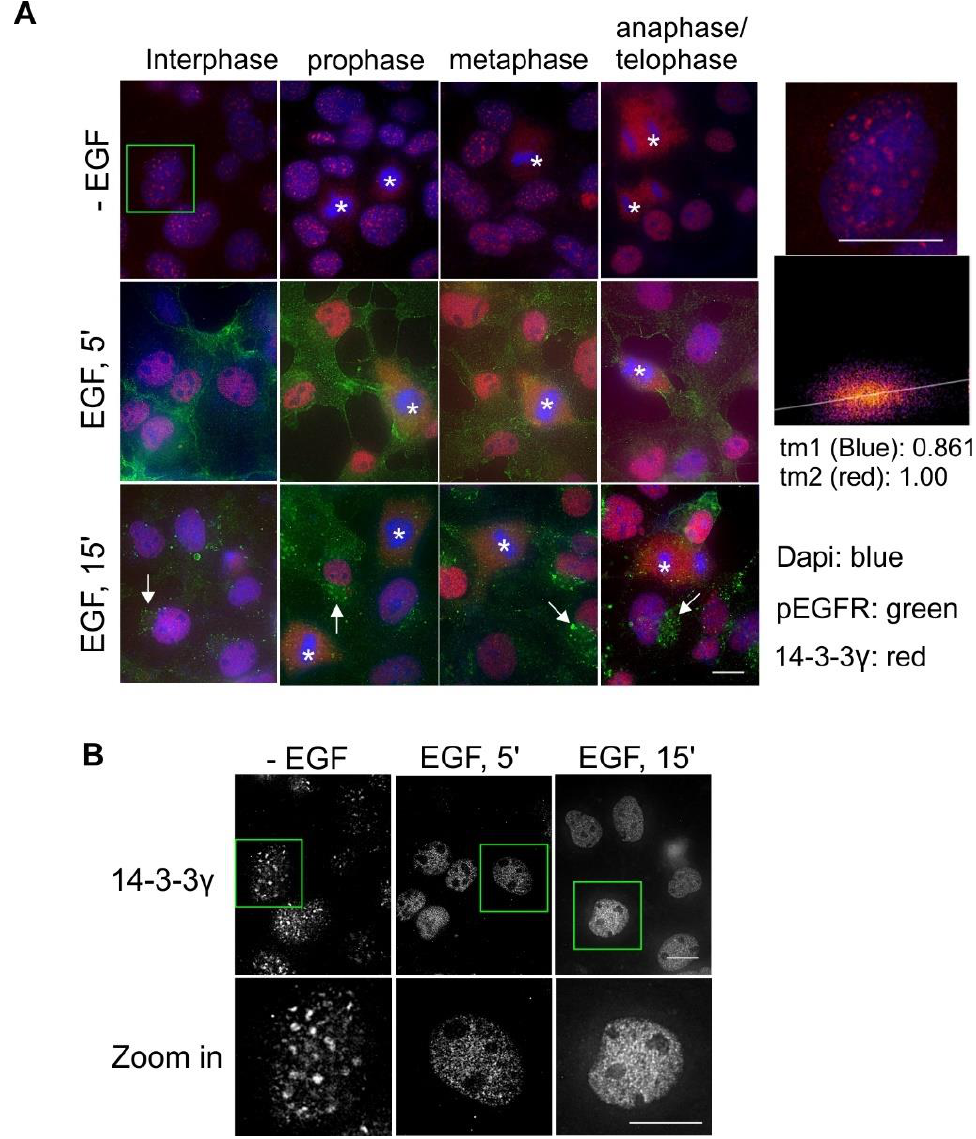
Figure 7. Subcellular localization of 14-3-3γ in Cos-7 cells by double indirect immunofluorescence. ( A ) Subcellular localization of 14-3-3γ during the cell cycle and in response to EGF. With or without EGF stimulation, 14-3-3γ (red) and pEGFR (green) were revealed by double indirect immunofluorescence. Mitotic cells are labeled by * and endosomes are marked by arrows. The zoomed-in areas were used to calculate Mander’s coefficients between blue and red channels. ( B ) Black and white images highlight the changes in the 14-3-3γ stain. The three images are the same as the three images in the far left panel in (A). Scale bar = 10 μm.